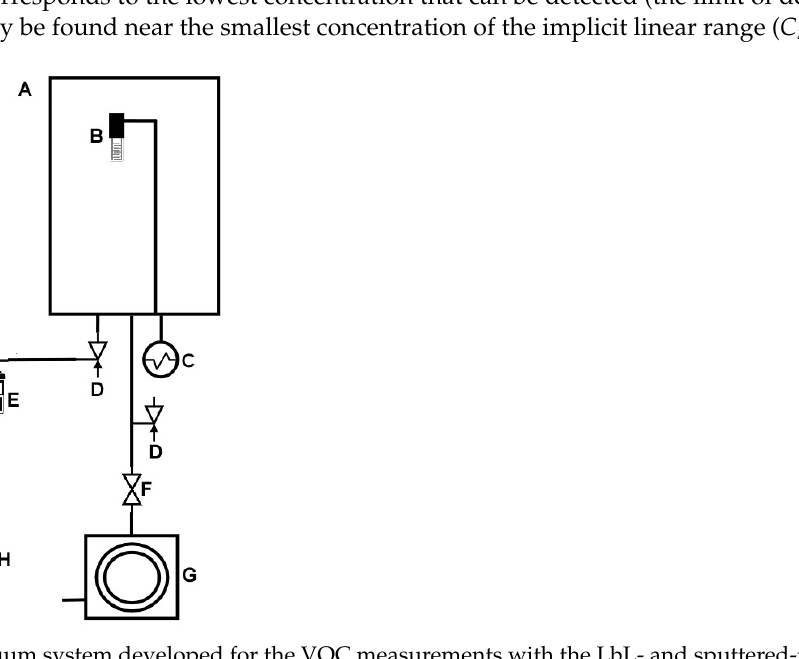
Figure 1. Vacuum system developed for the VOC measurements with the LbL- and sputtered-thin- film-based sensors. (A) vacuum chamber, (B) sensor device, (C) Pirani gauge, (D) inlet needle valve, (E) VOC evaporation flask, (F) gate valve, (G) rotary vacuum pump, (H) compressed reservoir.